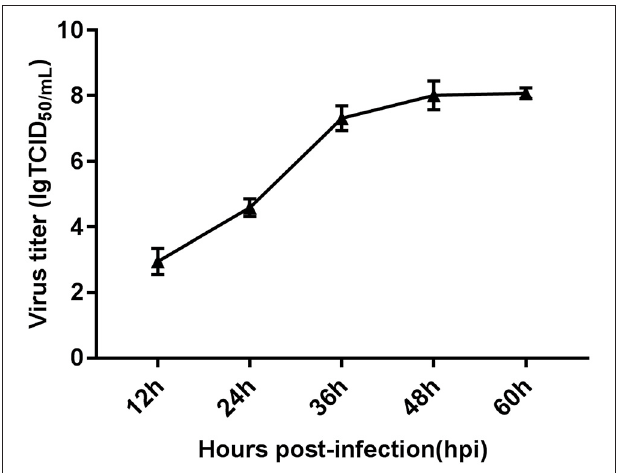
FIGURE 1 | Characteristics of FAdV-4-infected LMH cells assessed via viral replication analysis. One-step growth curve of FAdV-4-infected LMH cells at a multiplicity of infection of 0.1, obtained using quantitative real-time PCR. Each time point represents the mean ± SEM of the Hexon gene from the FAdV-4 genome. SEM, standard error of the